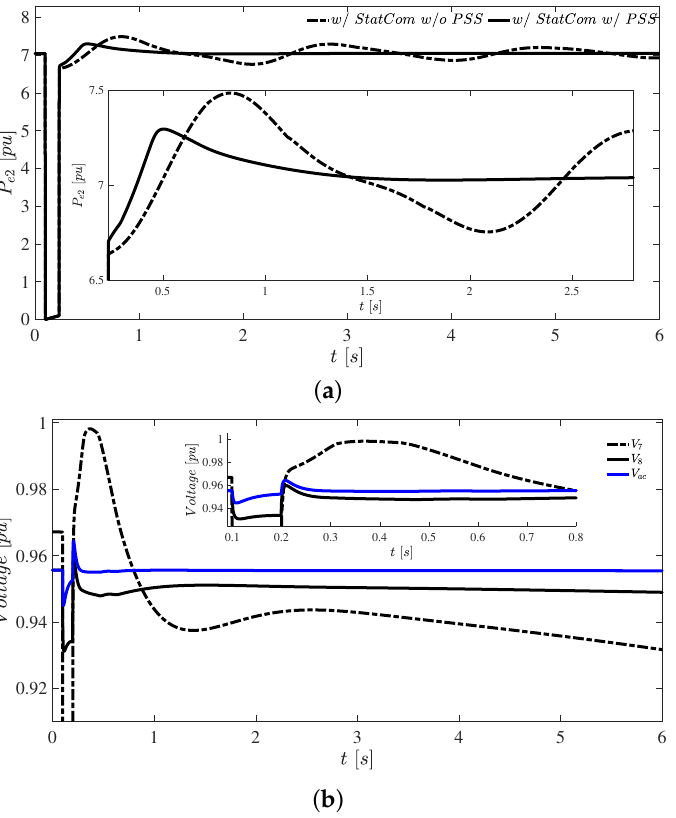
Figure 9. Case 2: ( a ) real power at generator 2; ( b ) voltage magnitude in bus of StatCom